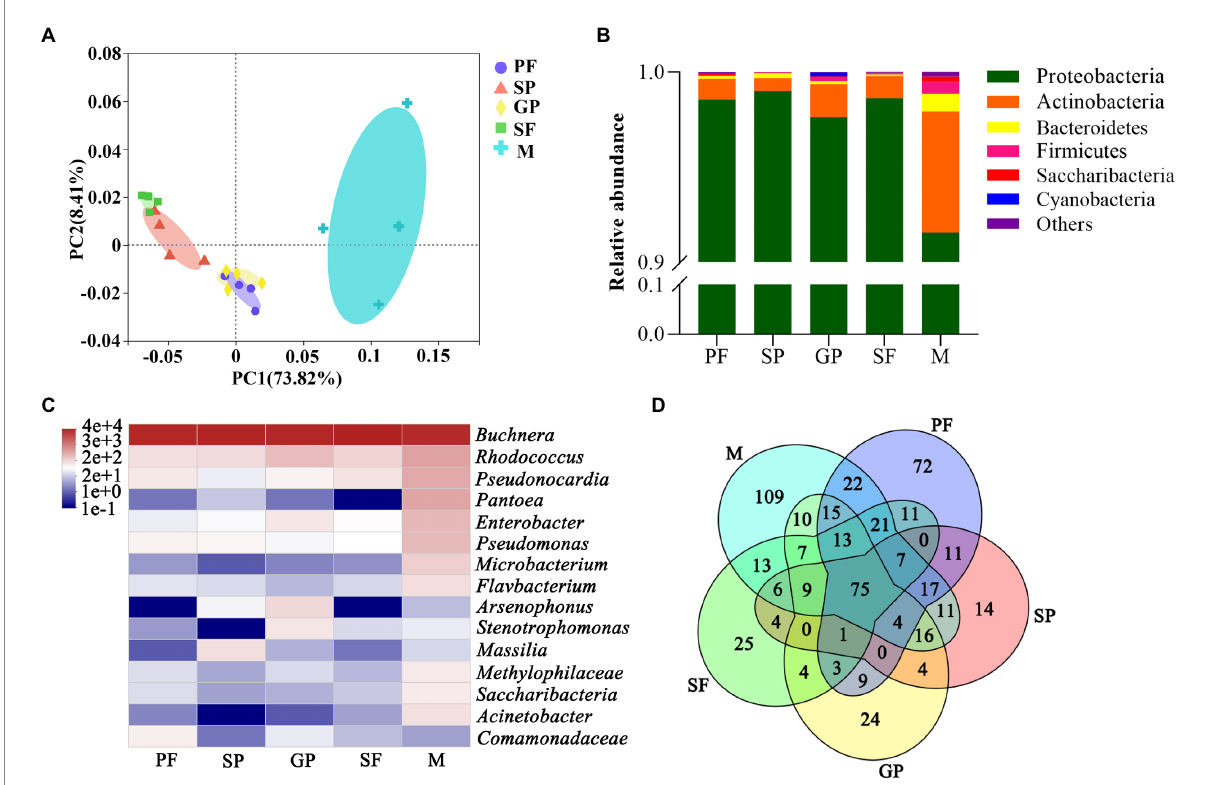
FIGURE 2 Dynamic changes of symbiotic bacterium communities during reproductive morph switch of A . gossypii . (A) Principal component analysis (PCA) of 20 samples from five reproductive morphs of A . gossypii . (B) Relative abundance of symbiotic bacteria in five reproductive morphs of A . gossypii at phylum level. (C) Heatmap of top 15 dominant microbial genera based on log2-transformed relative abundance. (D) Venn diagram of shared and exclusive bacteria in five reproductive morphs at species level. PF, parthenogenetic females; SP, sexuparae; GP, gynoparae; SF, sexual females; M,